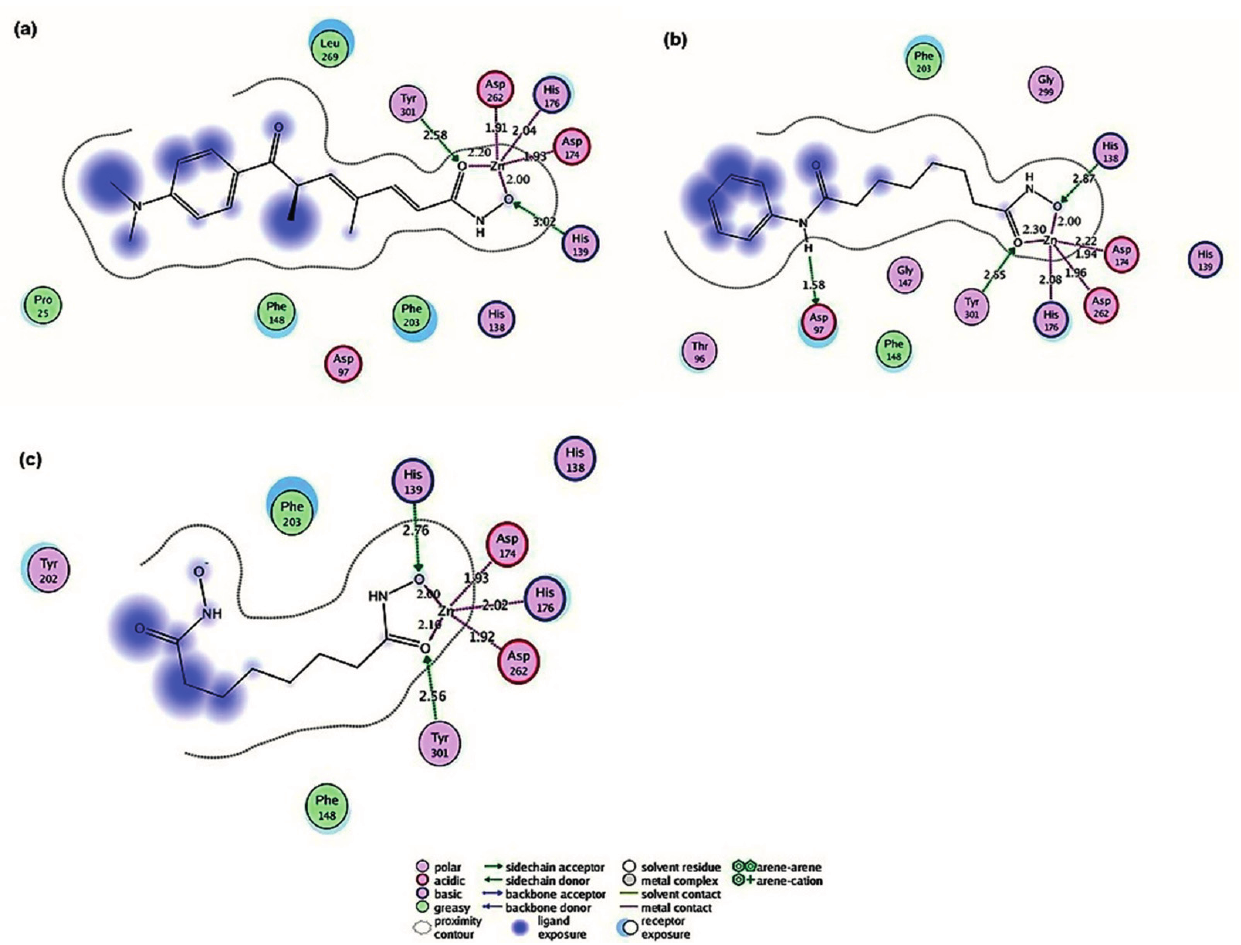
Figure 6. Pf HDAC1 model-ligand interactions. ( a ) TSA; ( b ) SAHA; and ( c ) SBHA. Bond distances are shown in